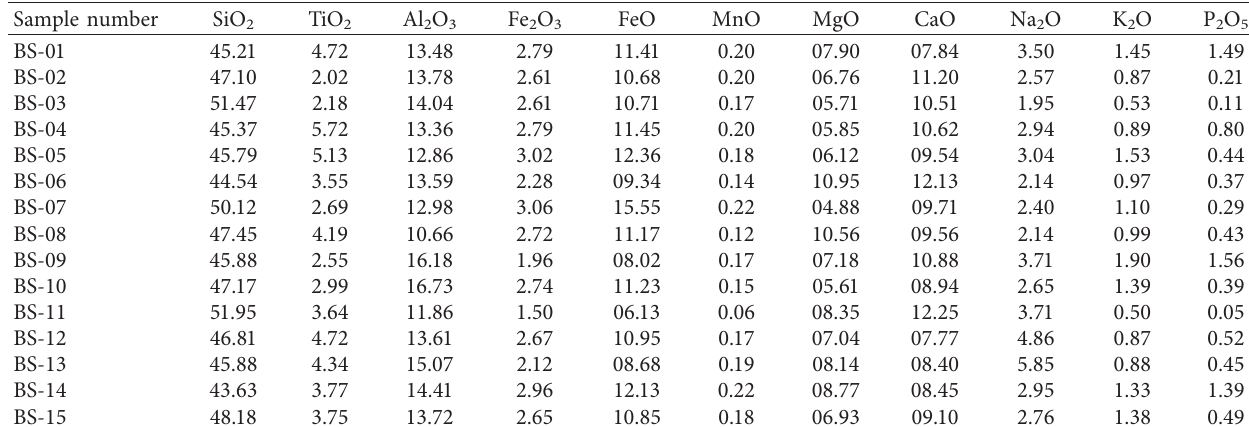
Figure 1: Experimental setup. (a) Transient Plane Source sensor sandwiched between two sample halves. (b) Circuit diagram with the data acquisition system. Table 1: Chemical composition of basalt rocks.